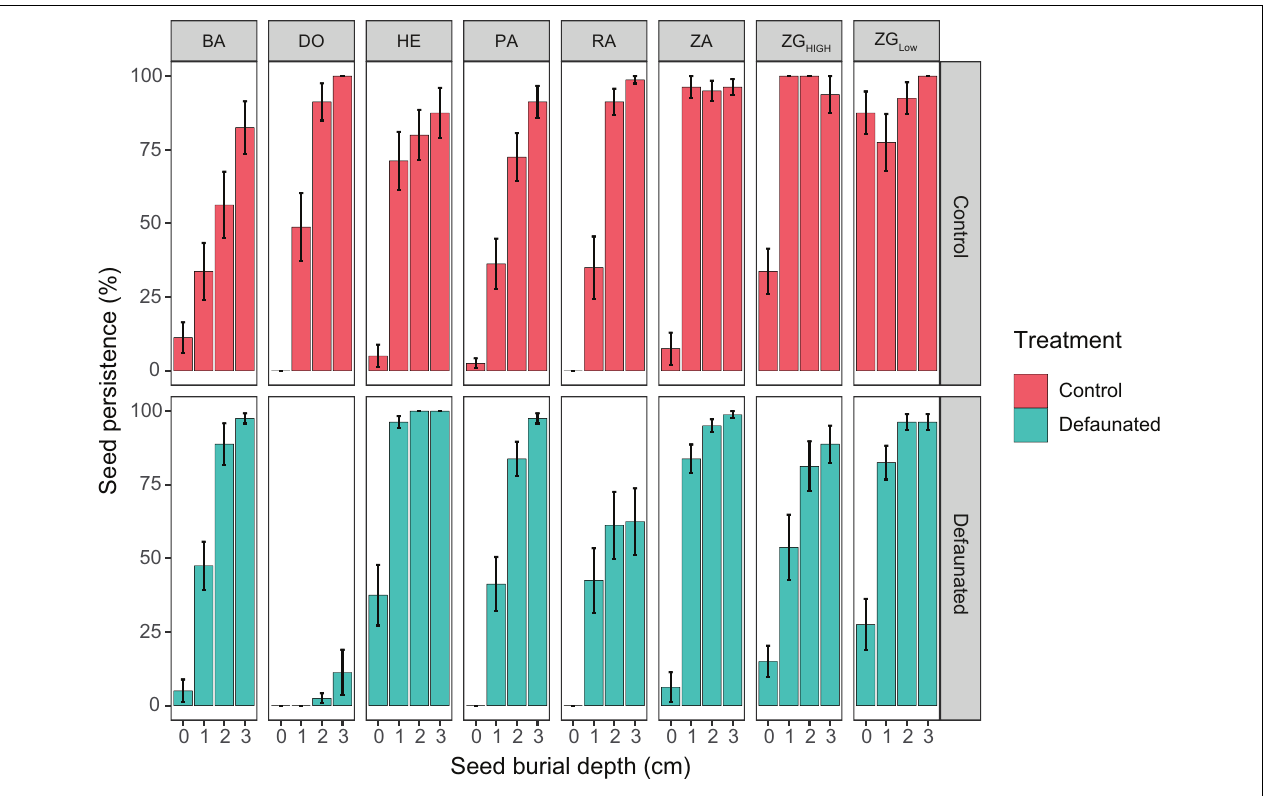
FIGURE 4 | The persistence of the manipulated seed bank at each study location, which was shown for the decaudated treatment (green bars) and the control (red bars), separately.